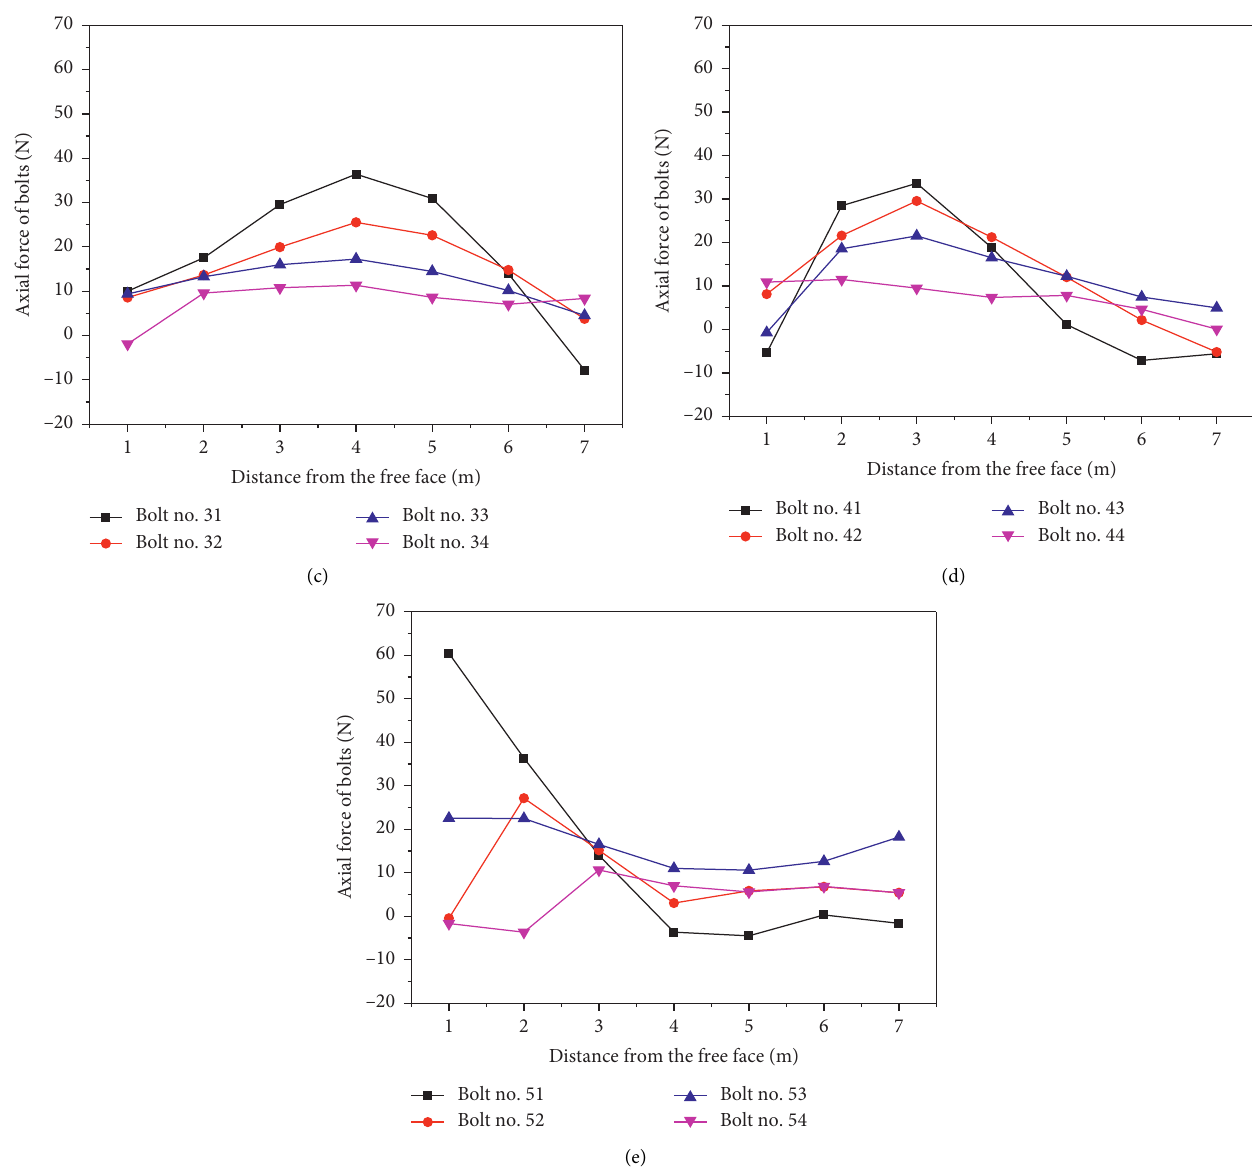
Figure 13: Bolt axial force